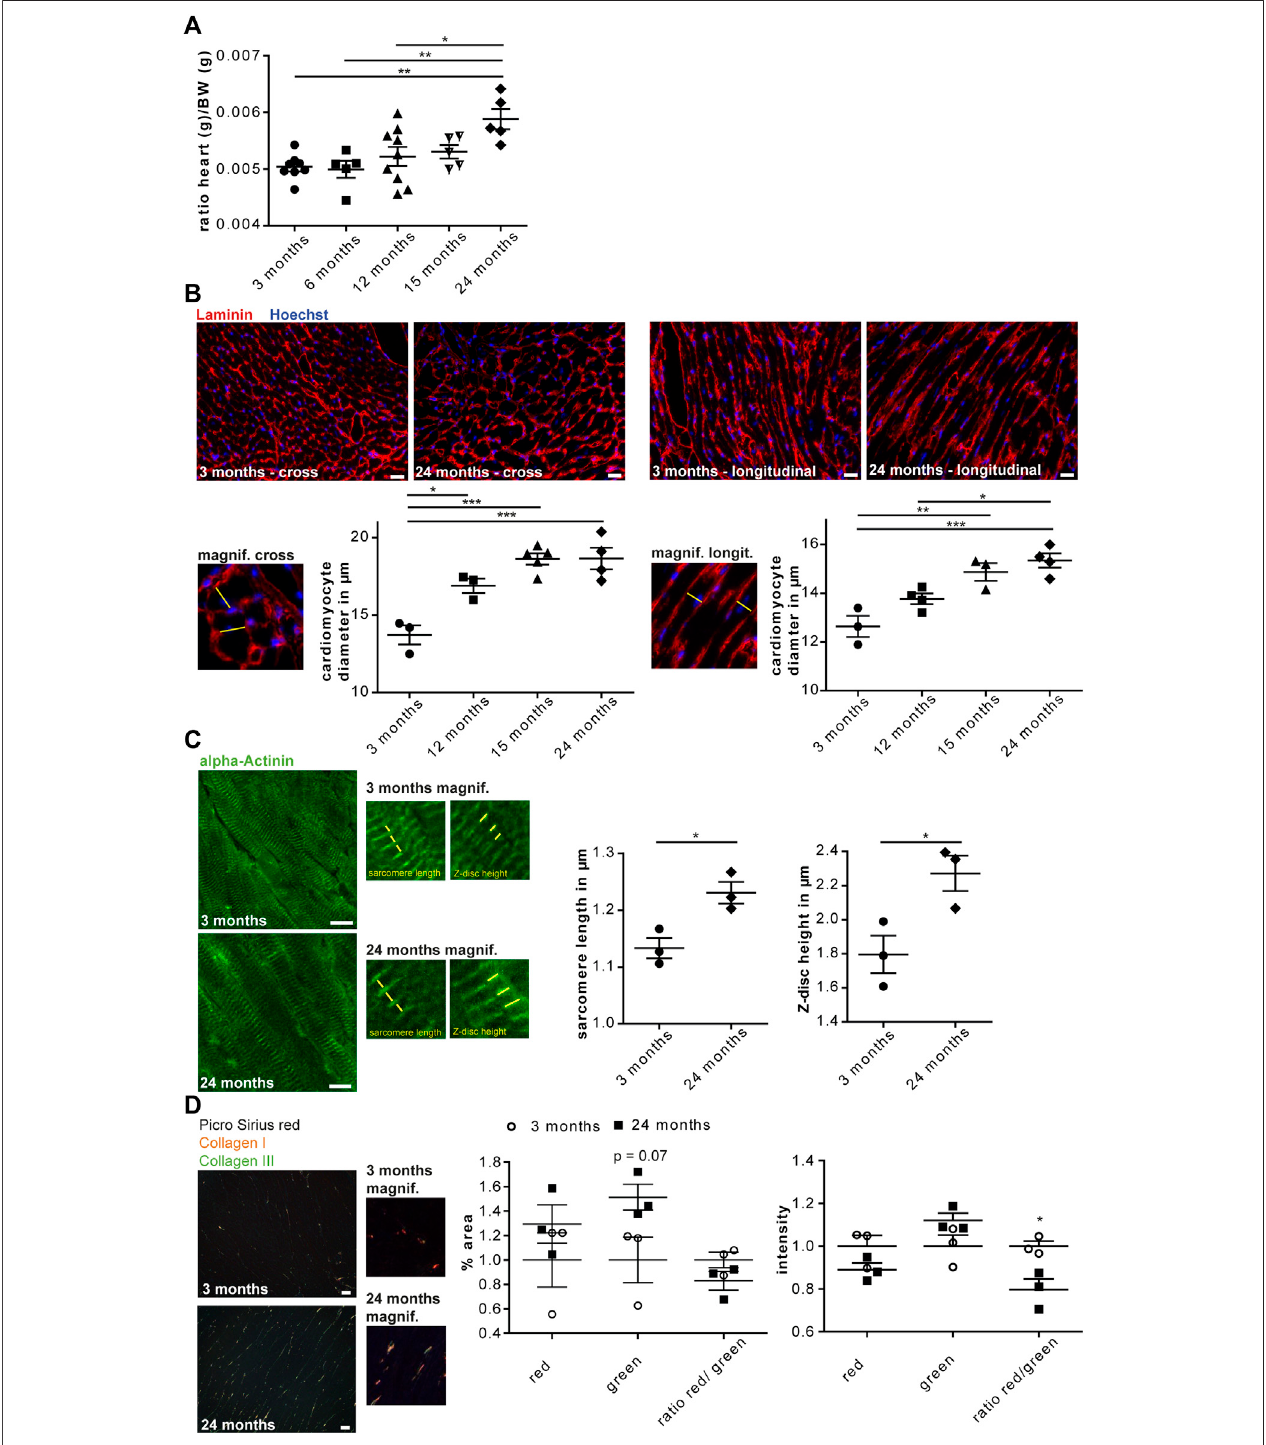
FIGURE 1 | Cardiac aging in male C57BL/6J mice. (A) The heart/body weight ratio increases during aging ( n (cid:2) 5 – 9 mice per age; 1-way ANOVA with Bonferroni posthoc test). (B) Representative images of either cross (left) or longitudinal (right) heart sections of a 3 and 24-month-old mouse are shown (scale bar: 20 µm). Left panel: Higher magni fi cation of cross-sectioned cardiomyocytes. An exemplary cardiomyocyte diameter is indicated (yellow line). The mean cell diameter of cross- sectioned cardiomyocytes increases with age ( n (cid:2) 3-5 mice per age, N (cid:2) 300 cells per mouse, 1-way ANOVA with Bonferroni posthoc test). Right panel: Higher magni fi cation of longitudinally sectioned cardiomyocytes. An exemplary cardiomyocyte diameter is indicated (yellow line). The mean cell diameter of longitudinal-